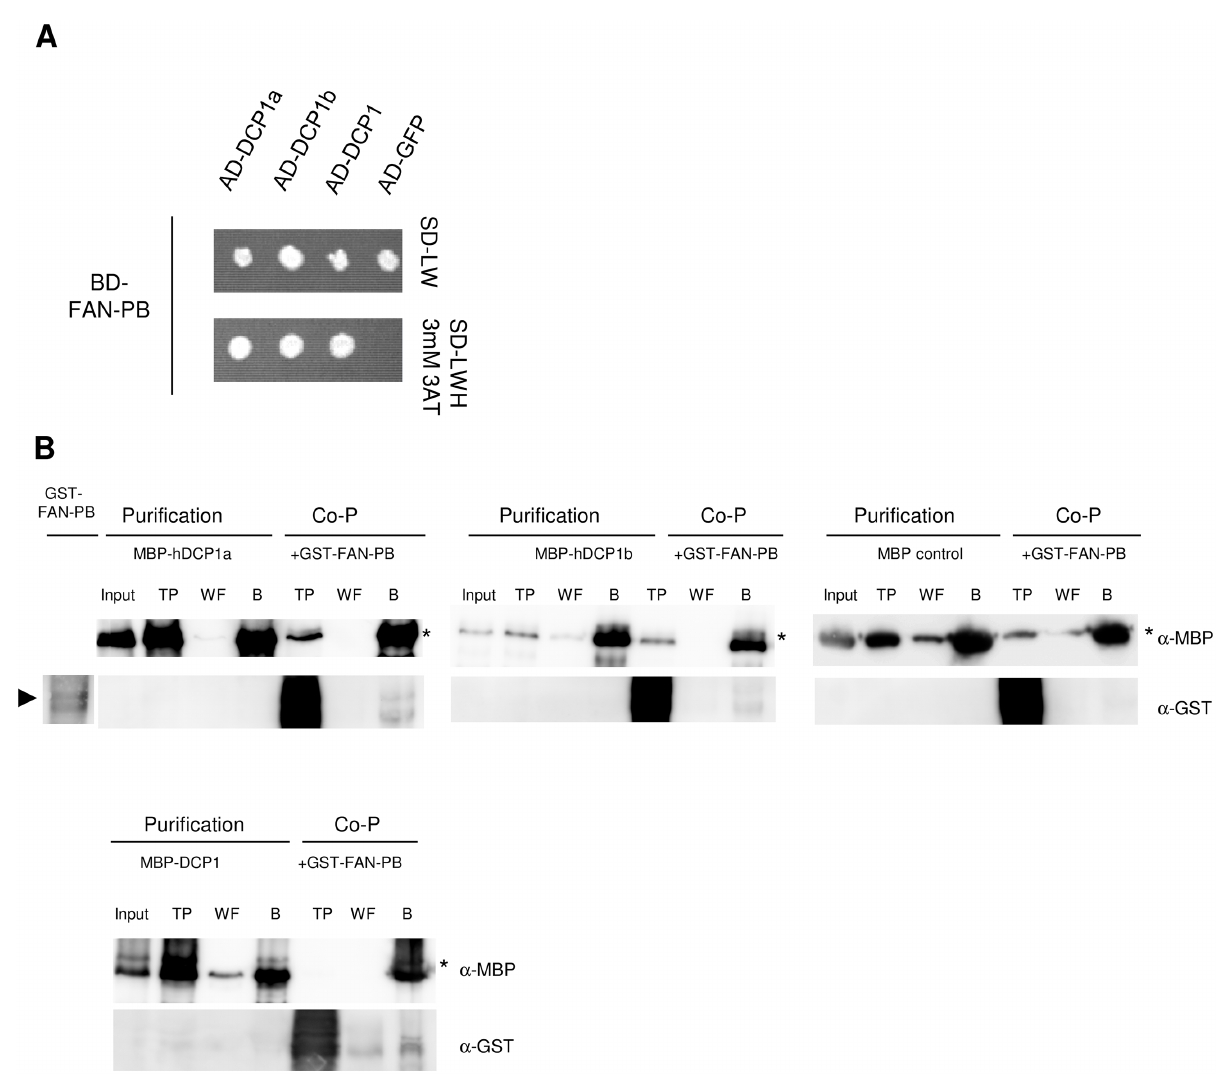
Fig 11. Inter- and intraspecific interactions between FAN-PB and DCP1 homologs. (A) Yeast two-hybrid interactions. Top part: double transformed yeast cells on selective dropout medium lacking leucine (-L) and tryptophan (-W). Bottom part: interactions between the FAN-PB N-terminally fused to the GAL4 Binding Domain (BD), the human DCP1 isoforms (DCP1a and b) and the Arabidopsis DCP1, N-terminally fused to the GAL4 Activation Domain (AD) on selective dropout medium lacking leucine (-L), tryptophan (-W), and histidine (-H), supplemented with 3 mM 3-Aminotrizole (3AT). GFP N-terminal fused to the GAL4-AD has been included as negative control. (B) Coprecipitations of bacterially expressed proteins. GST-FAN-PB (arrowhead, ~70 kDa) coprecipitated with MBP-DCP1a (~90 kDa), MBP-DCP1b (~92 kDa) and MBP-DCP1 from Arabidopsis, but not with MBP (~42 kDa) as negative control. Throughputs (TP), last wash fractions (WF), and resin bound fractions (B) are visualized by α -MBP (upper row) and α -GST antibody staining (lower row). Samples detected on different blots are separated by